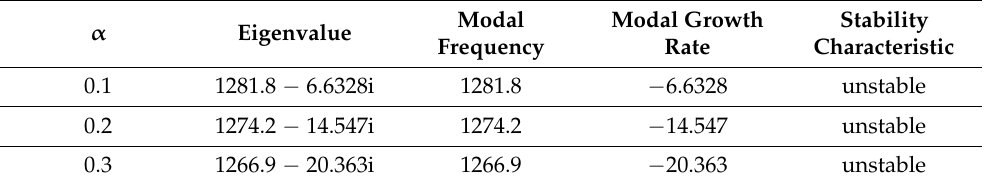
Table 6. Frequency and stability of first-order longitudinal, zero-order tangential, zero-order radial modes with different disturbance